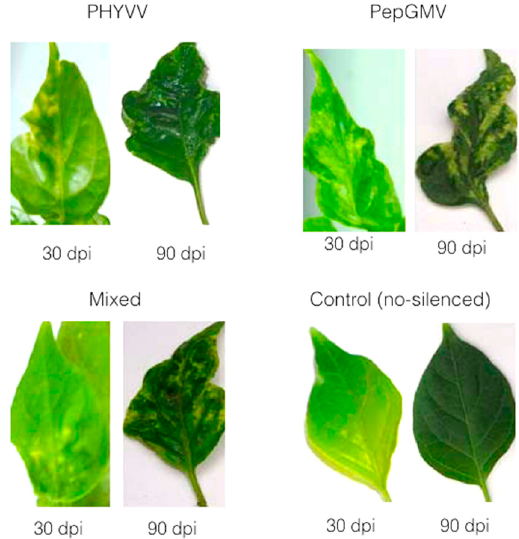
Figure 4. Typical symptoms in upper leaves of CchGLP ‐ silenced C. chinense BG ‐ 3821 at 30 and 90 dpi with PHYVV, PePGMV and mixed infections. Control means plants inoculated only with empty PHYVV ‐ A vector + wt component B and then PHYVV and PepGMV mixed infected.